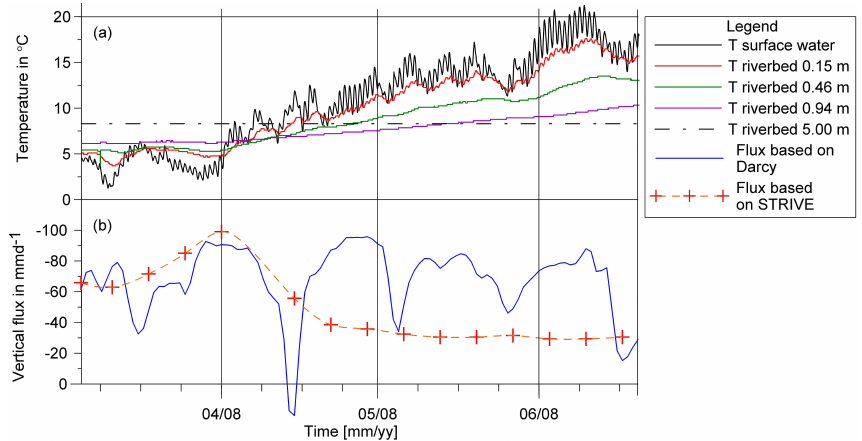
Fig. 9. (a) Surface water temperature and measured groundwater temperatures at different depths in piezometer nests No. 4. (b) Correspond- ing estimated fluxes using weekly transient thermal simulations with STRIVE as well as daily averaged fluxes based on Darcy